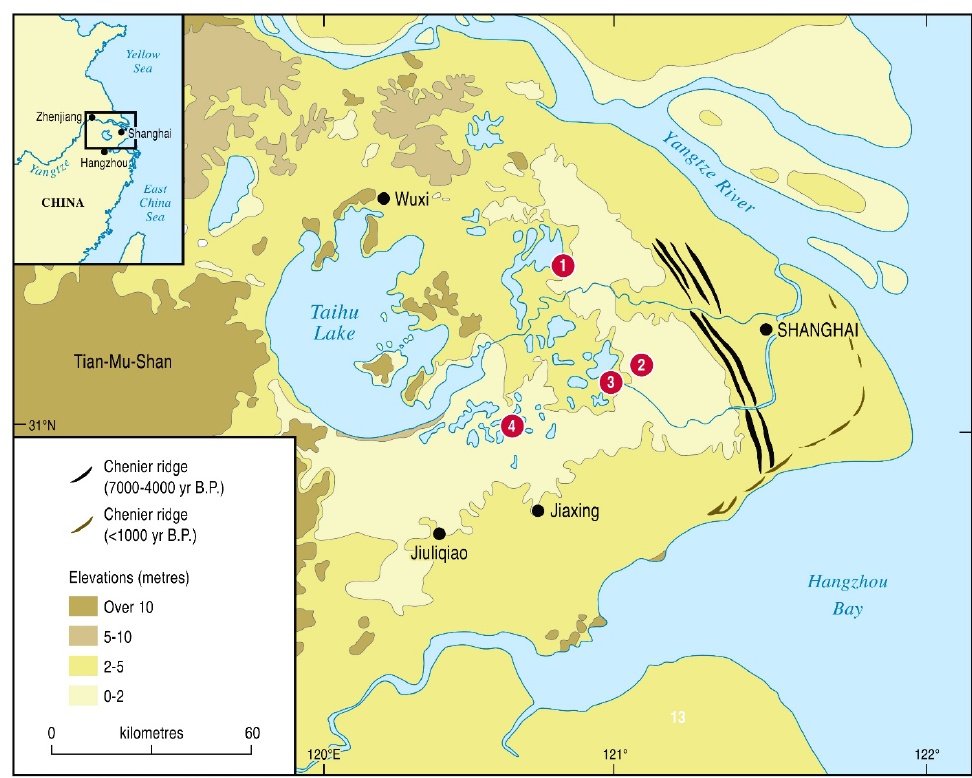
Figure 1. Location of the study area to the east of Taihu Lake in the Yangtze coastal plain, showing the topography, loca- tion of smaller lakes and the position of the four study sites 1. Chuodun 2. Tianyilu 3. Dianshan 4. Pingwang. Adapted from Innes et al. [81] with permission from Elsevier.